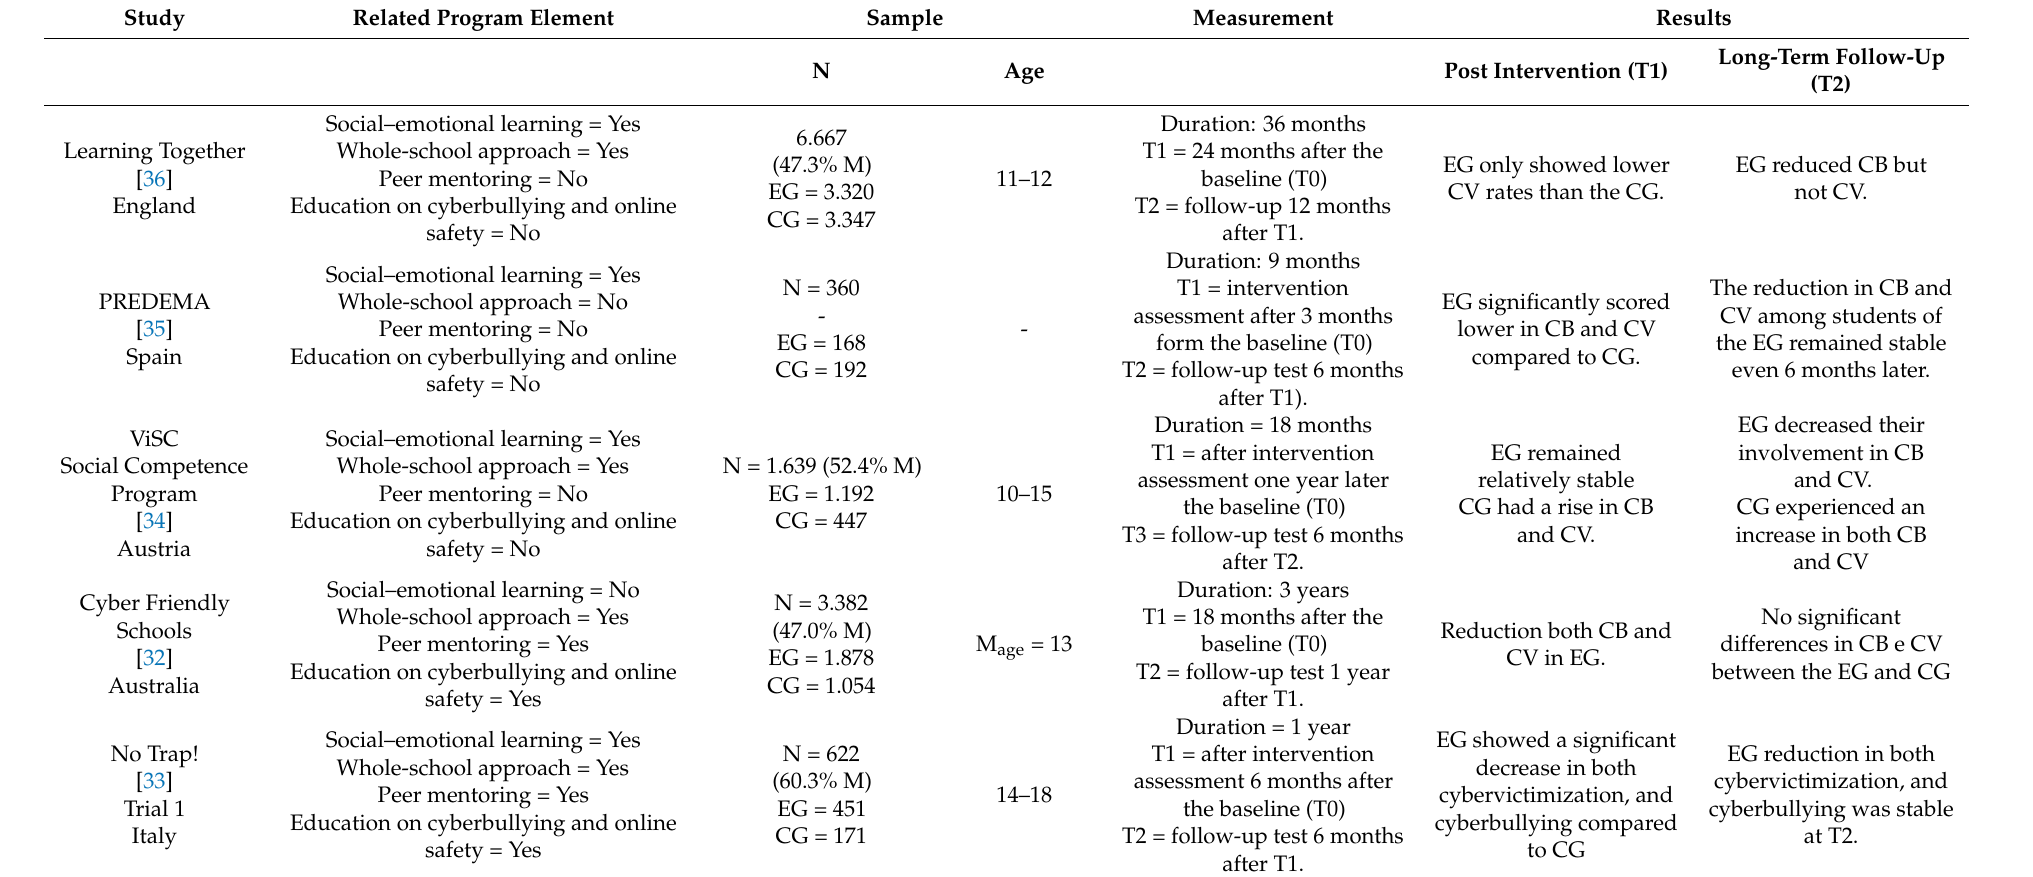
Table 1. Overview of anti-cyberbullying programs with a long-term